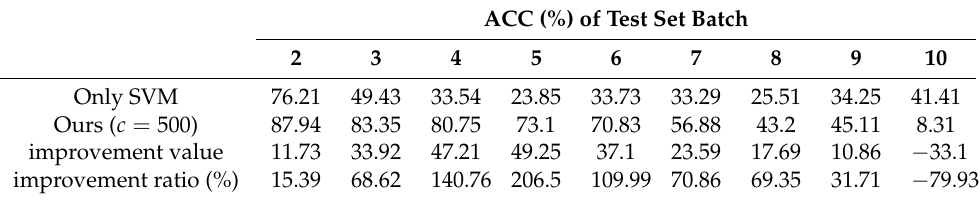
Table 7. Experimental comparison for dataset1.